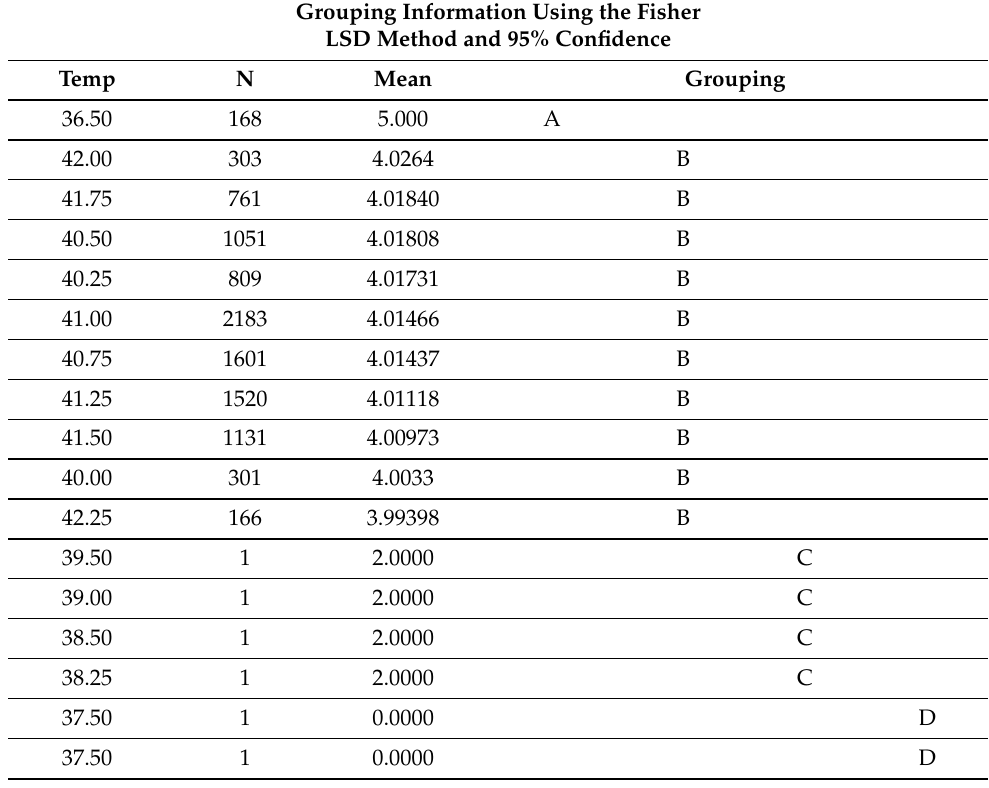
Table 4. Fisher analysis performed to determine the components to be used. Grouping Information Using the Fisher LSD Method and 95%